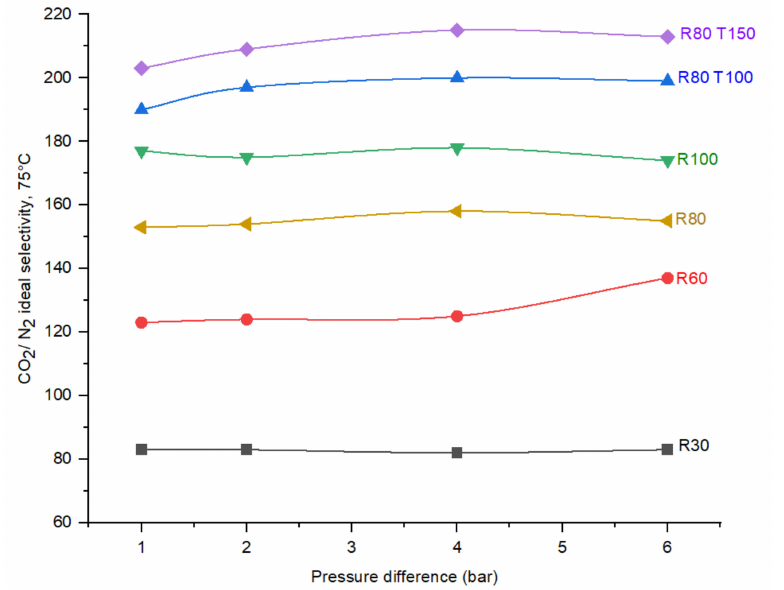
Figure 14. Effect of operational pressure on the CO 2 /N 2 ideal selectivity in the CMSMs (Carbon Molecular Sieve Membranes) with varying the DP (Degree of Polymerization) in the polymer and applied post treatment at permeation temperature of 75 ◦